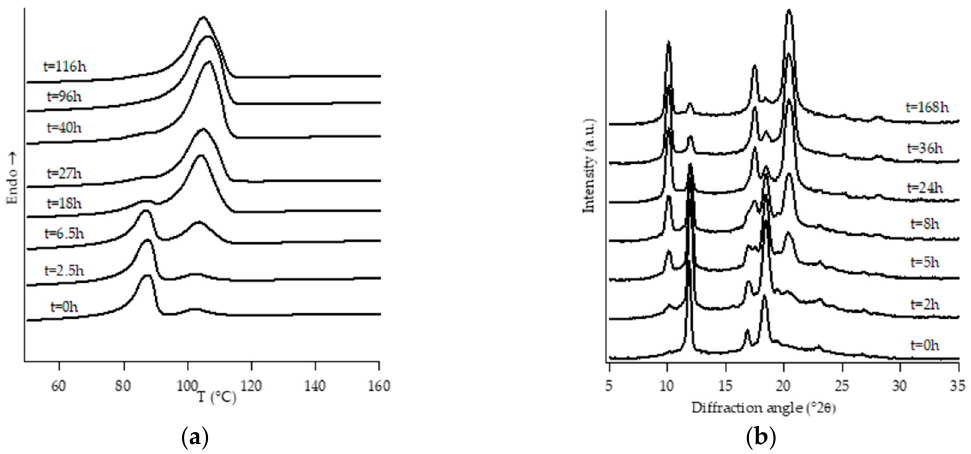
Figure 2. DTA thermograms ( a ) and WAXD patterns ( b ) of PB1 at different aging times.